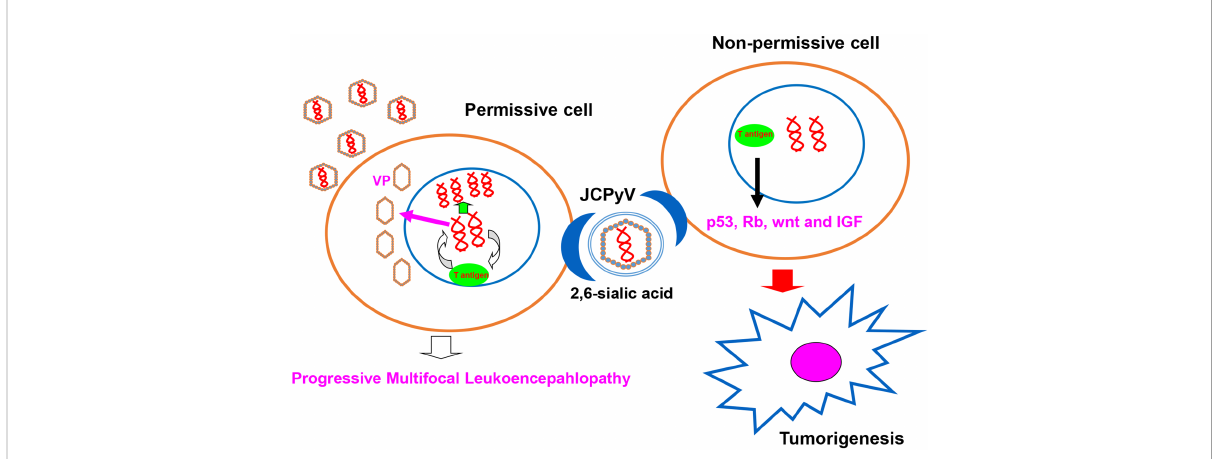
FIGURE 2 JCPyV infection outcome. JCPyV infection is initiated by its binding to JCPyV-sensitive cell surfaces. JCPyV capsids undergo endocytosis via capsid receptors (e.g., a 2, 6-linked sialic acid, non-sialylated glycosaminoglycans, and serotonin). In permissive cells, JCPyV may be activated for cell lysis and cause progressive multifocal leukoencephalopathy under immunosuppression (e.g., HIV infection, immunosuppressive drugs for organ transplantation, and cancer chemotherapy). In non-permissive cells, T antigen DNA from JCPyV can be inserted into genomic DNA, and T antigen can induce the malignant transformation of normal cells by targeting the p53, Rb, wnt, and IGF signal